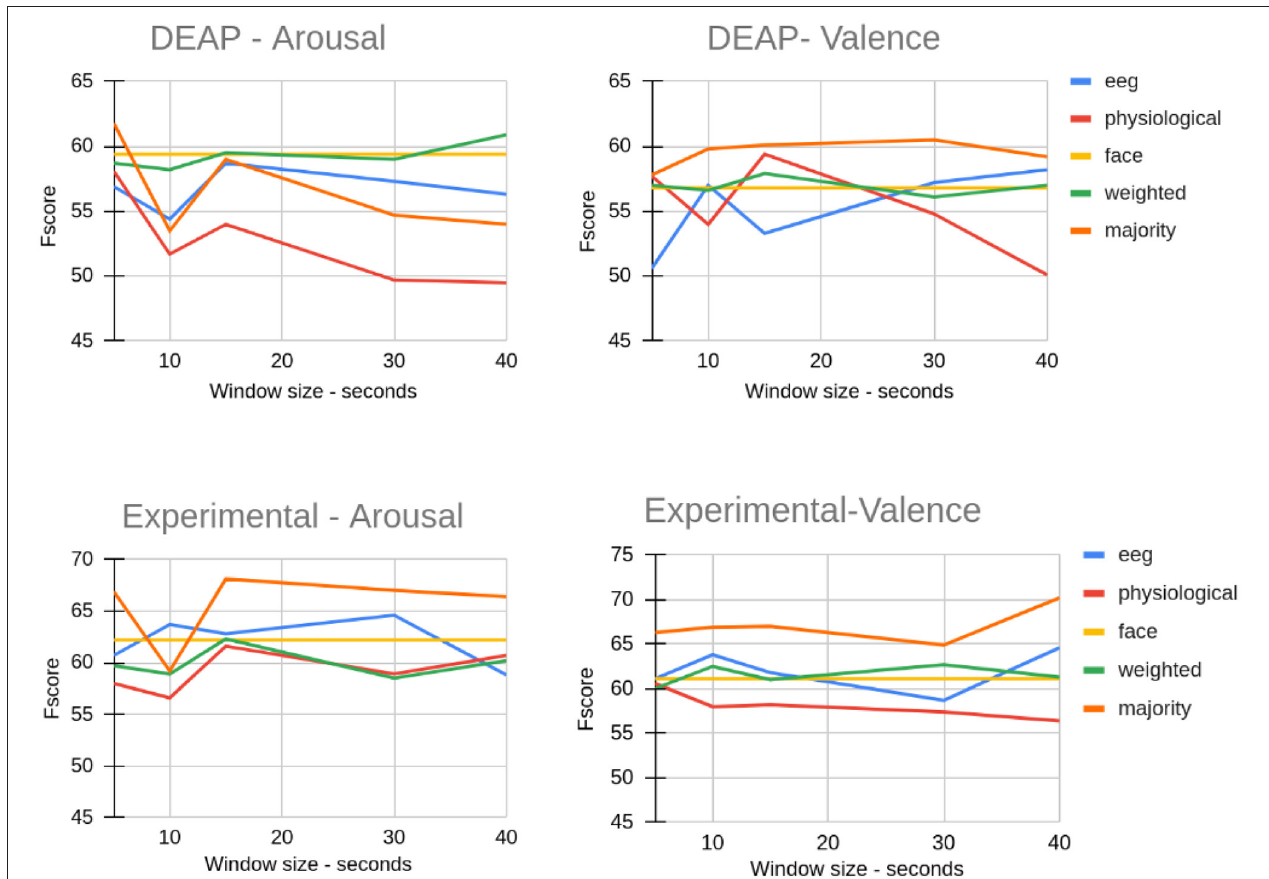
FIGURE 8 | The effect of ROI size on EEG, physiological, and fusion classification on the DEAP dataset and our experimental dataset (Window size 40 means all frames).